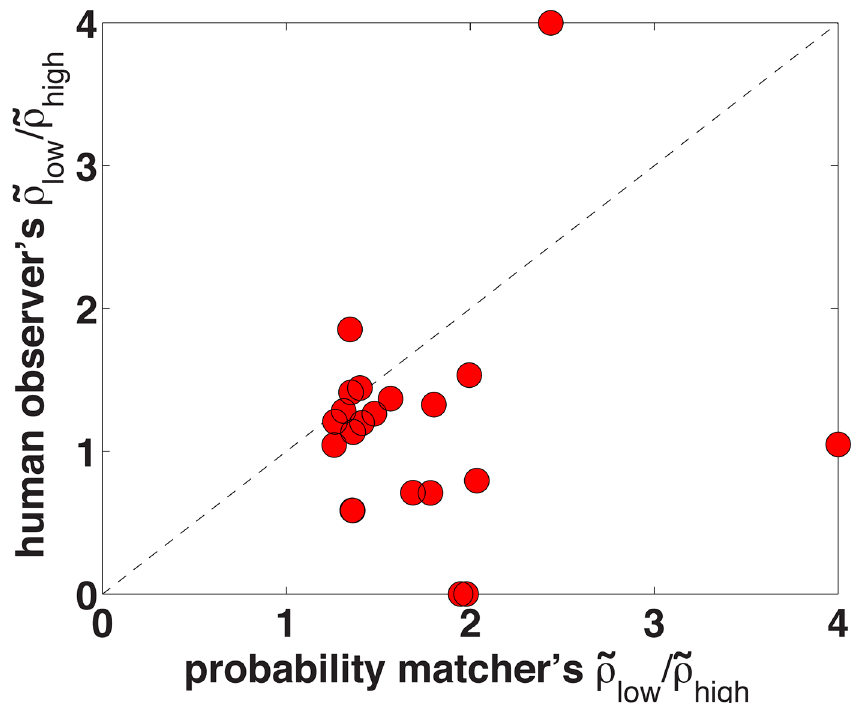
Fig 4. Ratio of apparent internal-to-external noise ratio at low and high performance levels. The x-axis shows the apparent internal-to-external noise ratio ~ r ~ shows the same ratio for human observers in Experiment